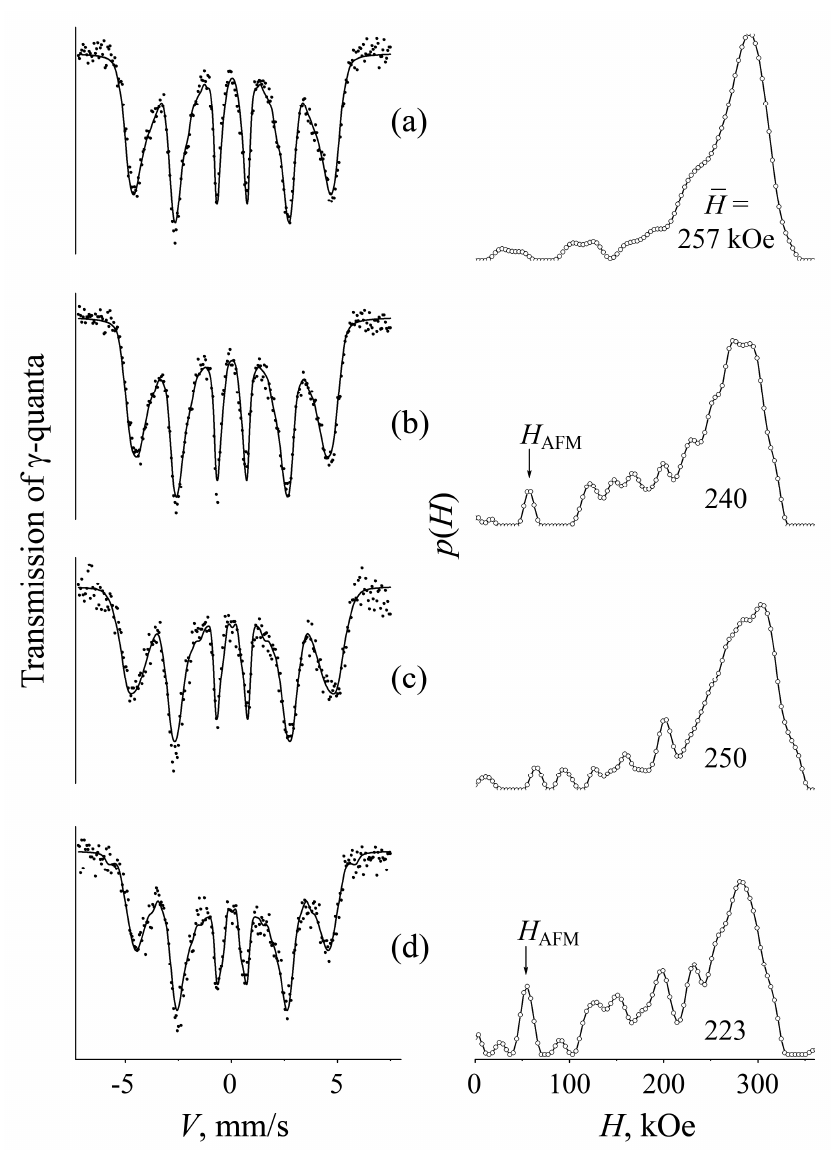
Figure 10. The structure of austenite of the steel Fe 64.7 Ni 33.6 C 1.7 . Treatment (state): ( a ), ( b ) annealed at 873 К for 1 h (aged); ( c ) aged and HPT treated at 80 К ; ( a ) optical metallography; ( b ) dark-field image taken in the combined reflection (211) (FeNi)3C ; ( c ) dark-field image taken in the combined carbide–austenitic reflection (111) γ .